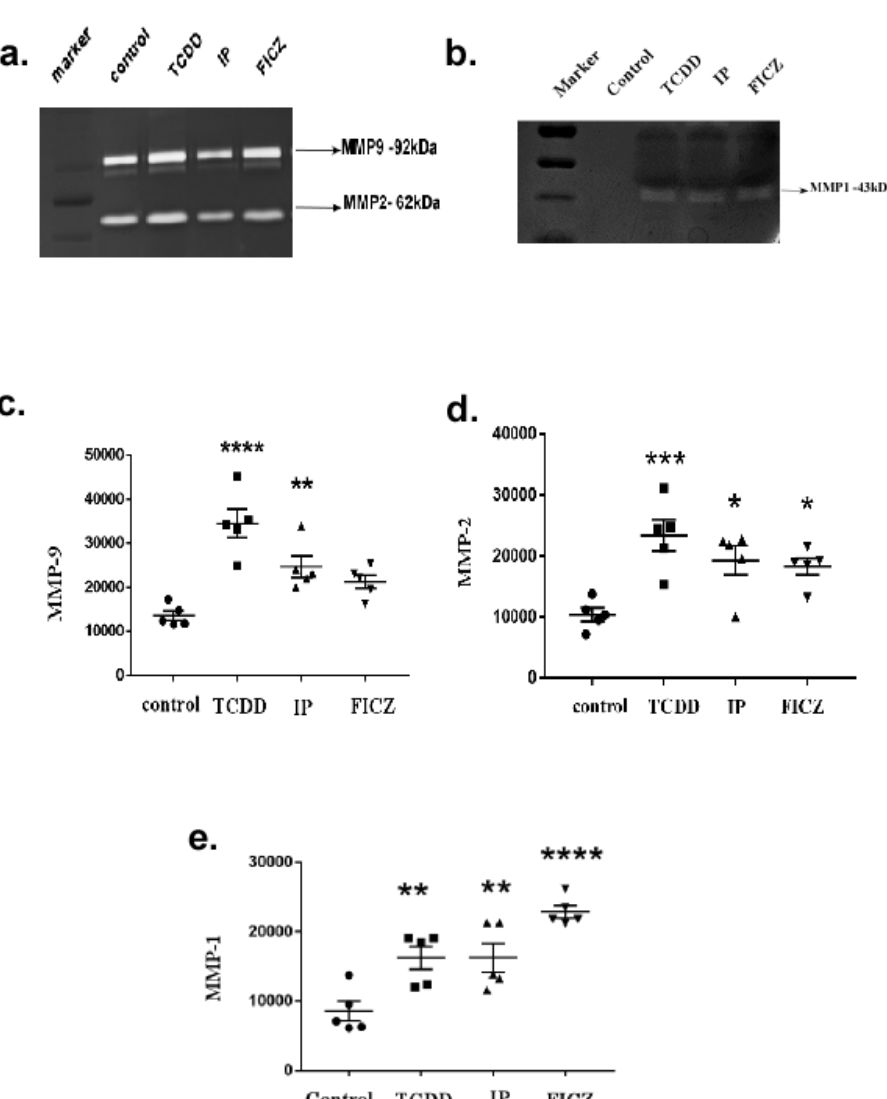
Figure 6. Activation of AhR induced MMP expression in RAW264.7 cells. In serum-free DMEM media with TCDD (10 −8 M), IP (10 −7 M), and FICZ (10 −7 M) for 24 h, RAW 264.7 cells were incubated. The cell supernatant was collected and subjected to SDS-PAGE (containing 0.1% gelatin or 1% casein) electrophoresis. ( a ) Representative image of gelatin zymogram. ( b ) Representative image of casein zymogram. Induction of RAW 264.7 cells with AhR agonists produced ( c ) MMP-9, ( d ) MMP-2, ( e ) MMP-1 expressions. The levels of secreted MMPs are shown as folds of increase compared to the control. Means of five independent experiments +/-SEM were represented in the graph. Unstimulated comparisons to control cultures were depicted by asterisks, such as * p < 0.05, ** p < 0.01, *** p < 0.001 and **** p < 0.0001 by one-way ANOVA analysis.